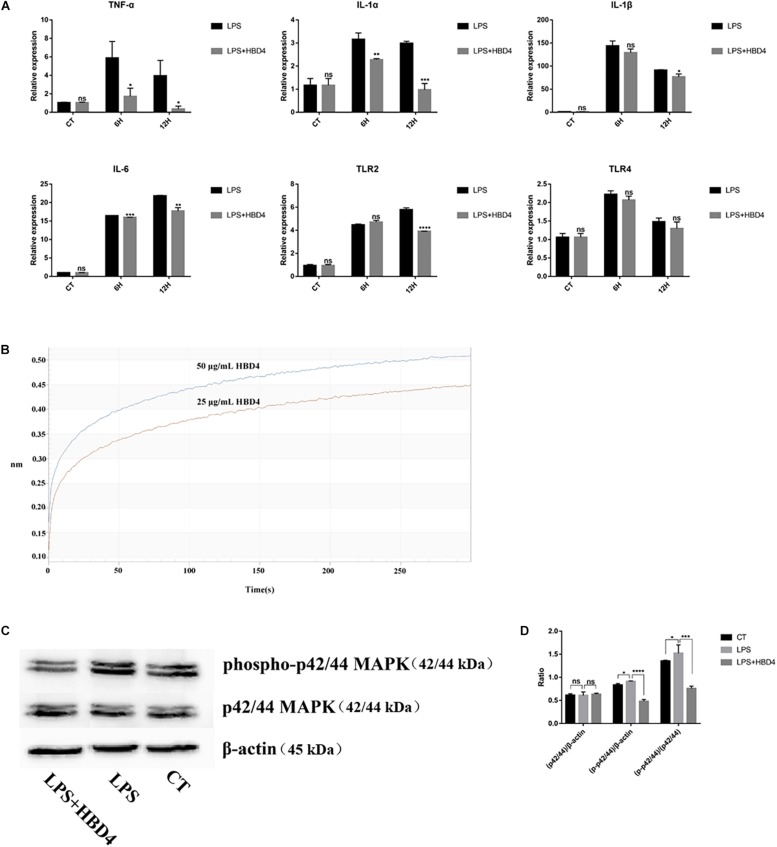
HBD4 regulated LPS-induced TNF-α, IL-6, IL-1α, IL-1β, TLR2 and TLR4 mRNA expression in SHED (A). Statistical comparisons are between LPS alone versus LPS with HBD4 at the same time point in each group. The interaction between HBD4 and LPS was analyzed by Octet optical biosensors (B); SHED were incubated with HBD4 and then LPS. Cellular proteins were extracted and separated by sodium dodecyl sulfate-polyacrylamide gel electrophoresis. Decreased intensity of phospho-p42/44 MAPK of HBD4 + LPS was detected in comparison with LPS alone (C). The quantification of the band density was determined using Image J software (D). The experiments were performed for three times. ∗P < 0.05; ∗∗P < 0.01; ∗∗∗P < 0.001; ****P < 0.0001; ns, no significance (CT, control; 6H, 6 h; 12H, 12 h).